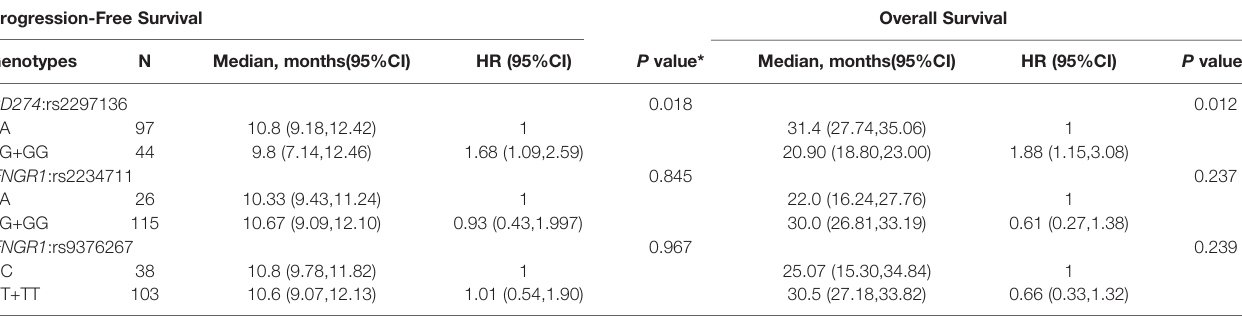
TABLE 3 | Association between genotypes and clinical outcome of mCRC patients treated with bevacizumab-based chemotherapy. Progression-Free Survival